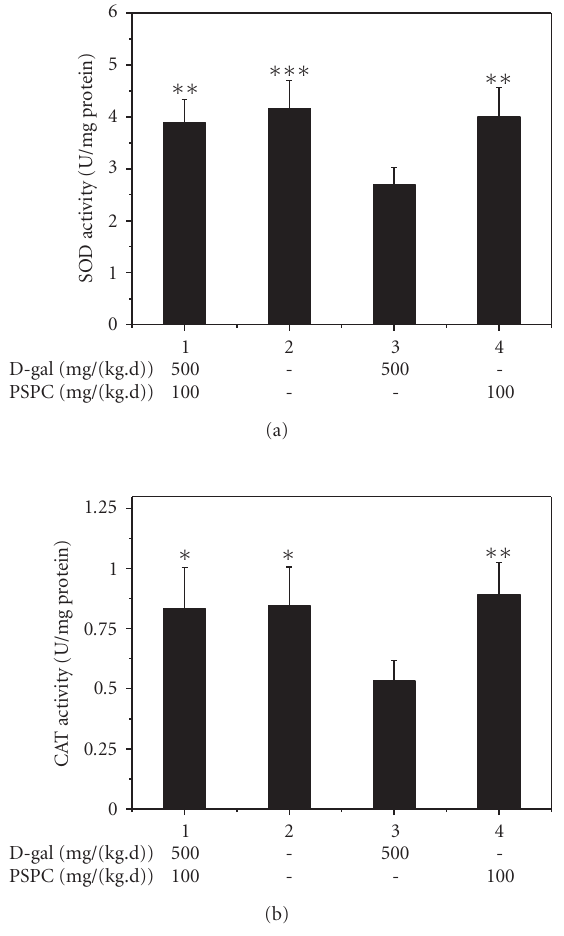
Figure 3: Pharmacological column for the e ff ect of PSPC on the activity of Cu/Zn-SOD (a) and CAT (b). Each value is the means ± SEM ( n = 5) . ∗ P < . 05, ∗∗ P < . 001, ∗∗∗ P < . 001 versus D-gal model.